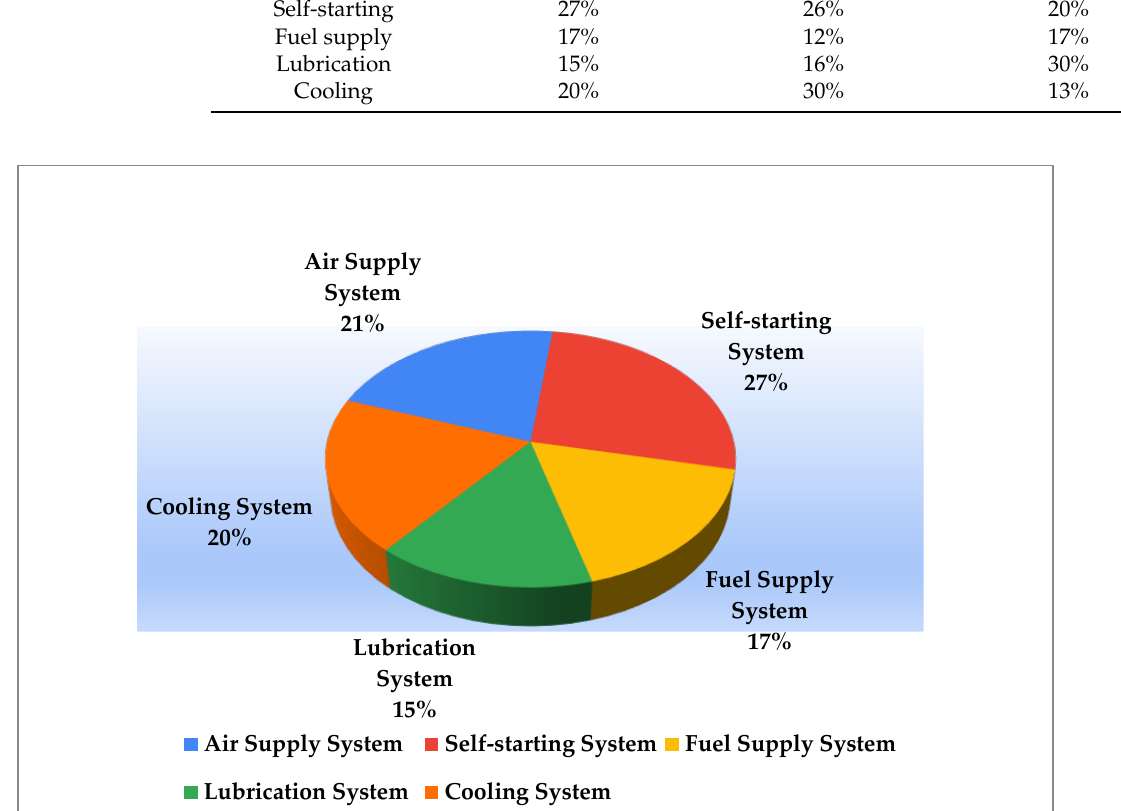
Figure 1. TBF Hours in percentage in comparison to total time for Engine 1.